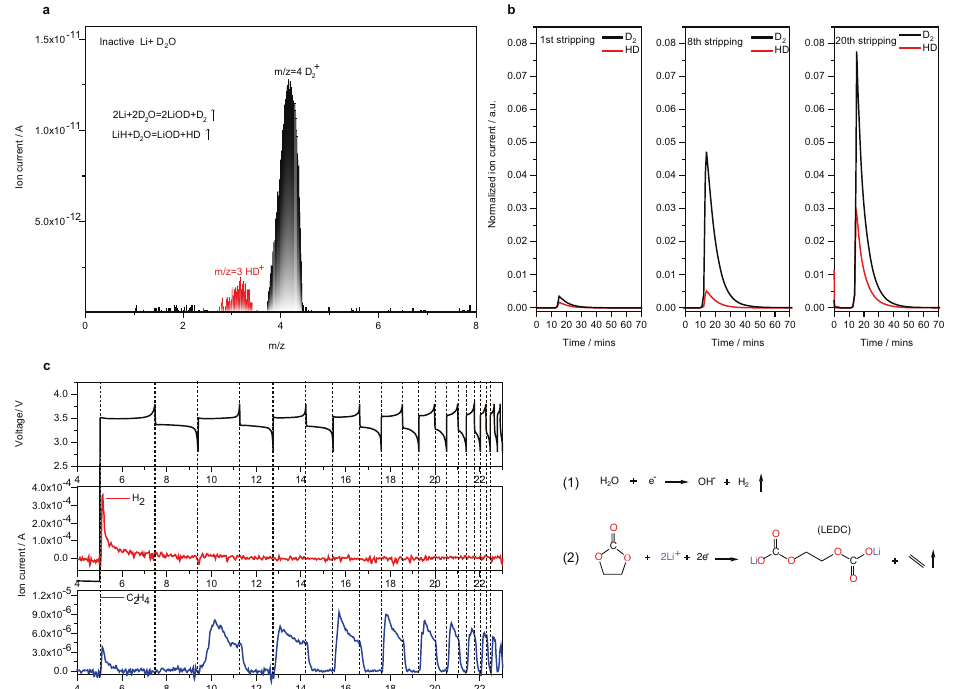
Fig.1|EvolutionofLiHandgasspeciesinCu||LiFePO 4 batteriesusing1MLiPF 6 / EC:EMC electrolyte. a The mass spectrum of gas products produced by reaction betweeninactiveLiwithD 2 O. b MassspectrometrytitrationresultsofdeadLimetal and LiH based on the reaction 2Li + 2D 2 O = 2LiOD + D 2 ↑ and LiH + D 2 O = LiOD +